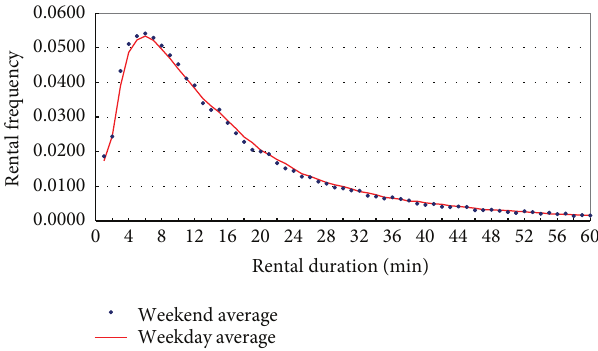
Figure3:Comparisonofrentaldurationdistributioncharacteristics for weekdays and